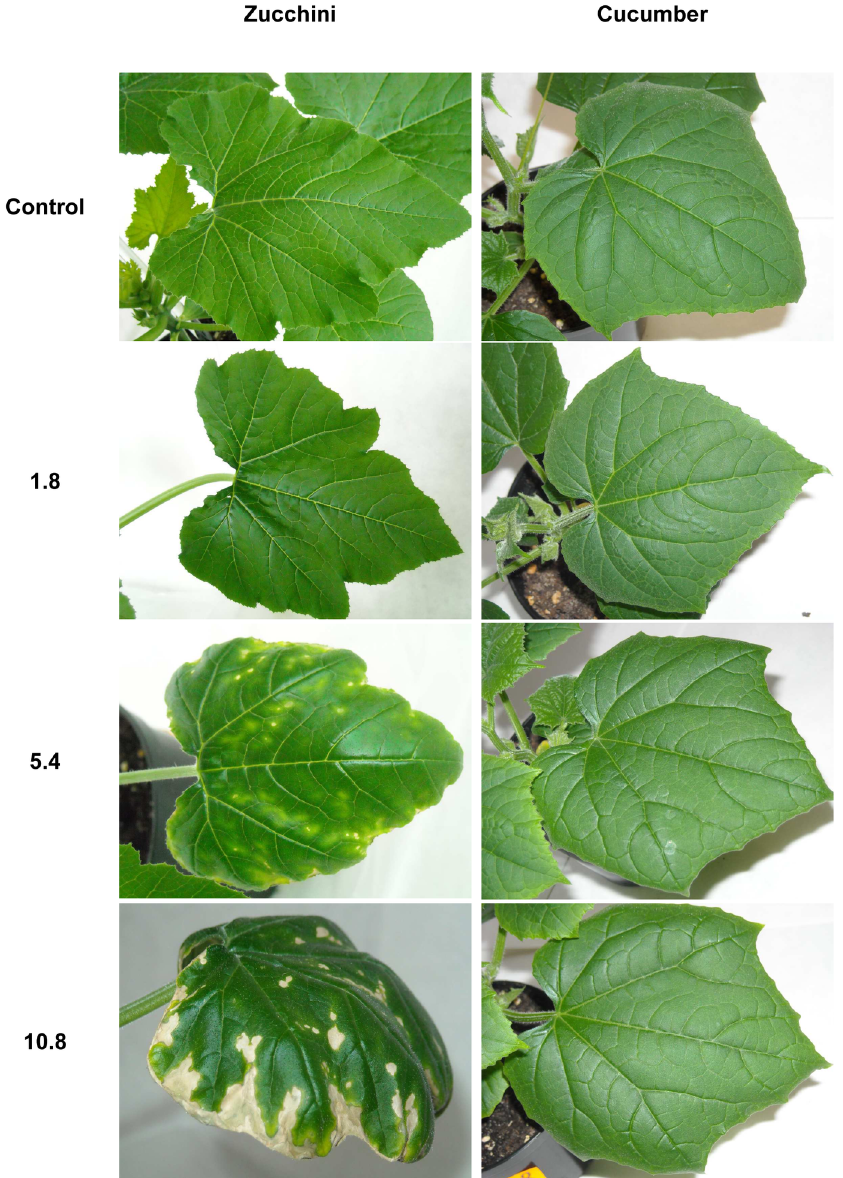
Fig 1. Visible injuries on leaves of zucchini and cucumber grown on the control and sewage sludge amended soil.